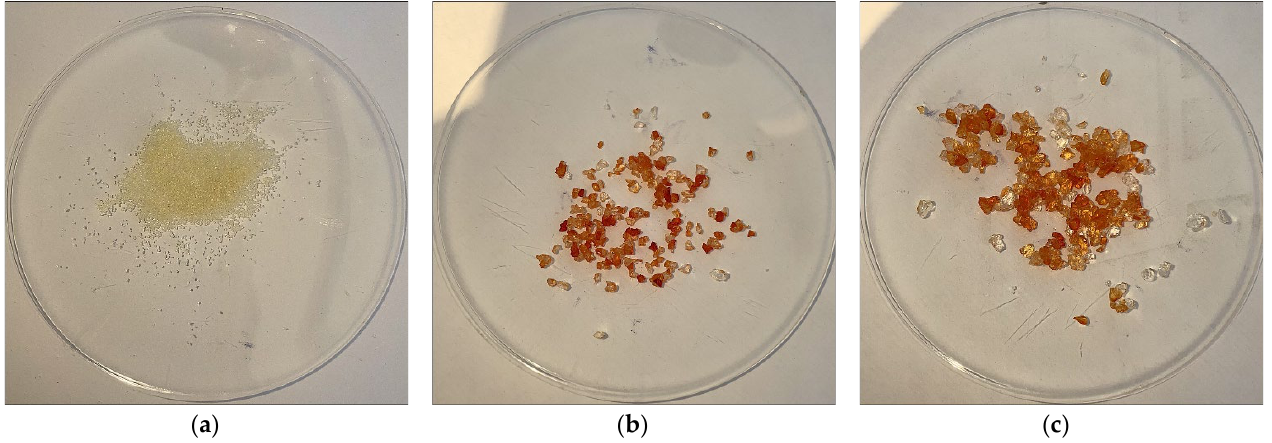
Figure 8. PPGs swelled in DIW for 24 h ( a ) dry PPG before being swelled, ( b ) swelled PAM 3.5% /Cs 0.5% , ( c ) swelled PAM 9% /Cs 0.5% .